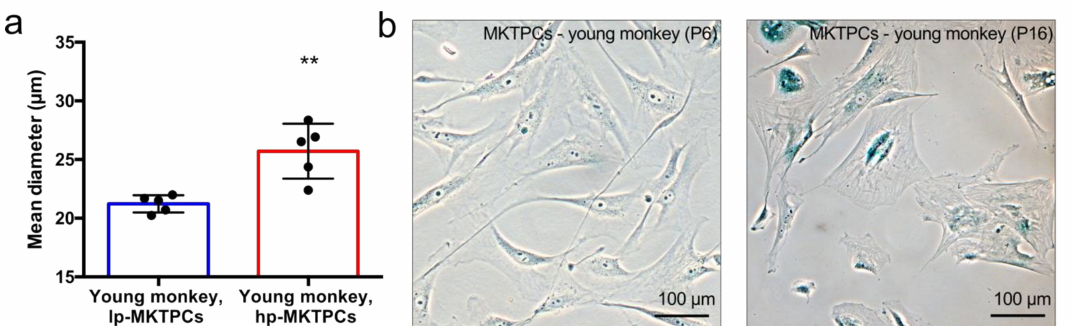
Figure 1. ( a ) Cell size measurement of low-passage-number vs high-passage-number testicular peritubular cells from the common marmoset (lp-MKTPCs vs. hp-MKTPCs) from the same donor animal. A significant increase in cellular diameter of hp-MKTPCs was shown. Columns indicate the mean; bars indicate the standard deviation; for statistics, a paired t -test was used. ( b ) Light micrograph of senescence-associated β -galactosidase staining of lp-MKTPCS and hp-MKTPCs. ** p -value < 0.005